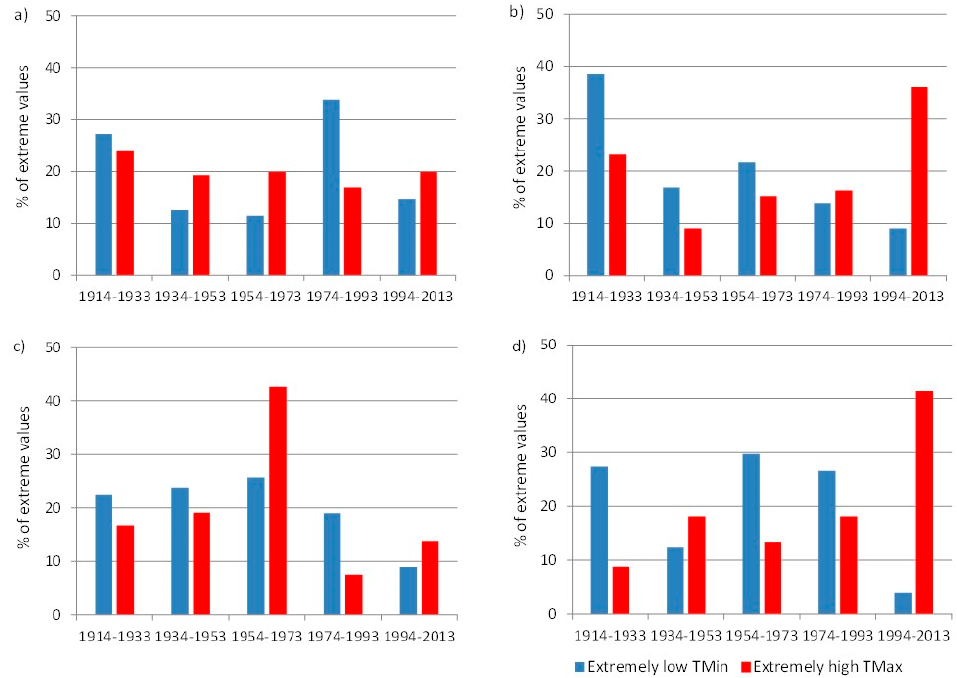
Figure 4. The total proportion of extremely low daily minimum temperatures and extremely high daily maximum temperatures (1st percentile of minimum temperatures and 99th percentile of maximum temperatures defined separately for each weather station) observed in 20-year study intervals in northern Fennoscandia. ( a ) January, ( b ) April, ( c ) July, and ( d ) October. (Stations 2, 4 and 5 excluded from maximum temperature calculations).